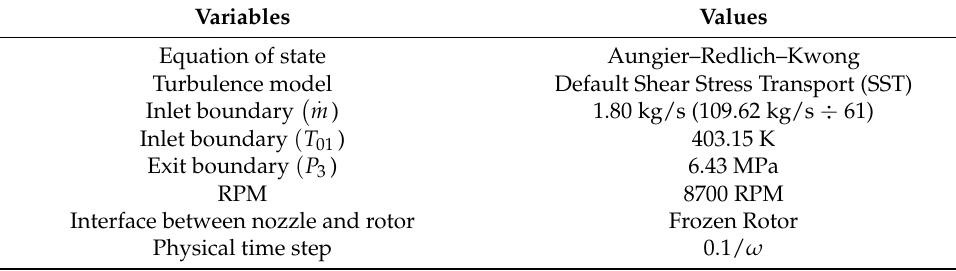
Table 4. Main models and boundary conditions of the turbine for CFD analysis.